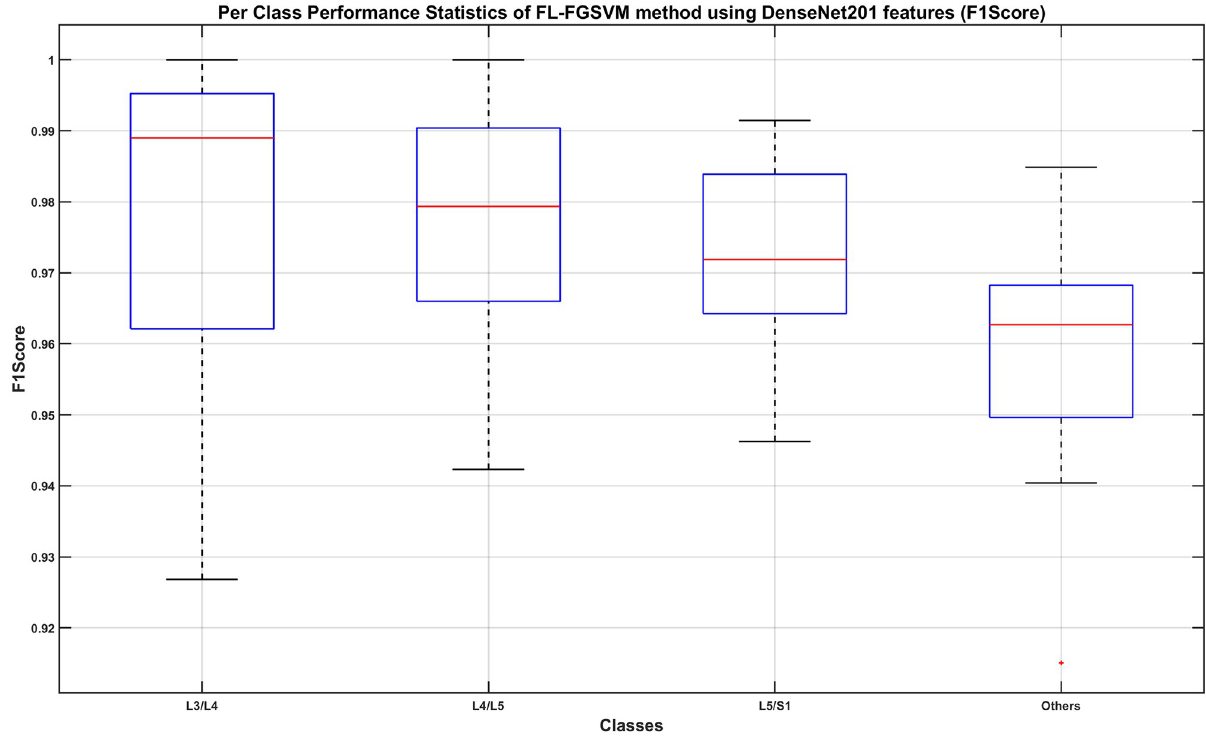
Fig 14. Per-class classification performance using Fine Gaussian SVM classifier on full-length DenseNet201 features (F1-Score).